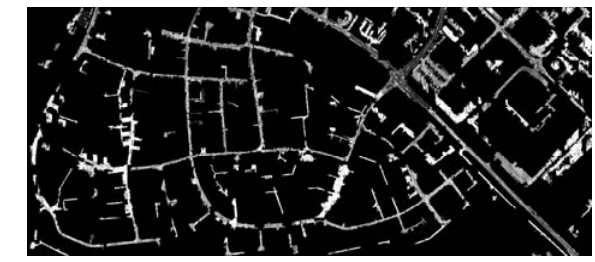
Figure 5. The main road frame